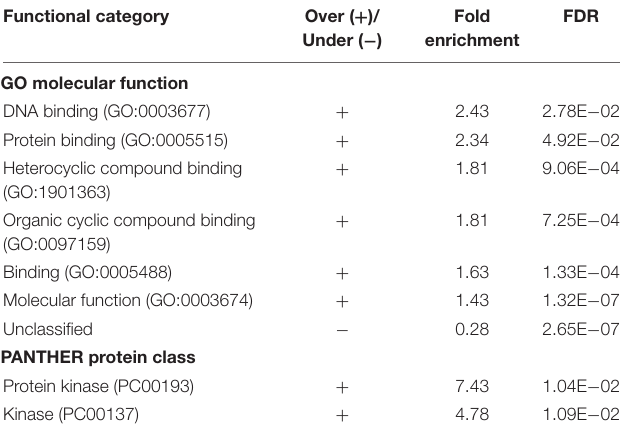
TABLE 2 | Enriched functional classes of the identified biofilm- and quorum sensing-associated proteins